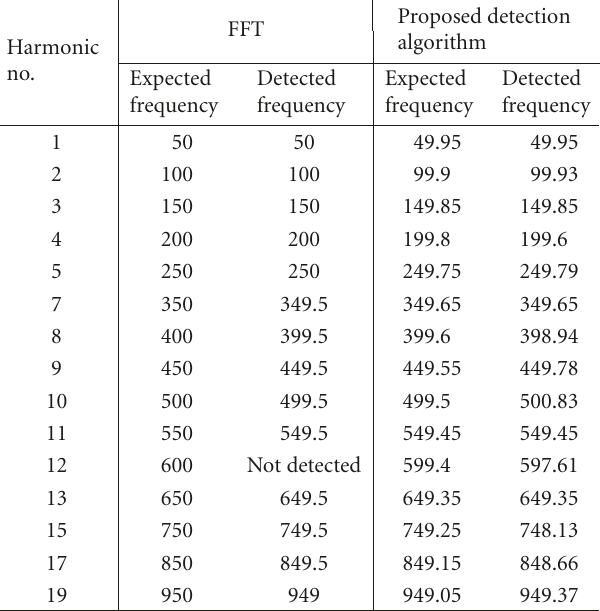
Table 9: Comparison of accuracy in harmonics estimation.